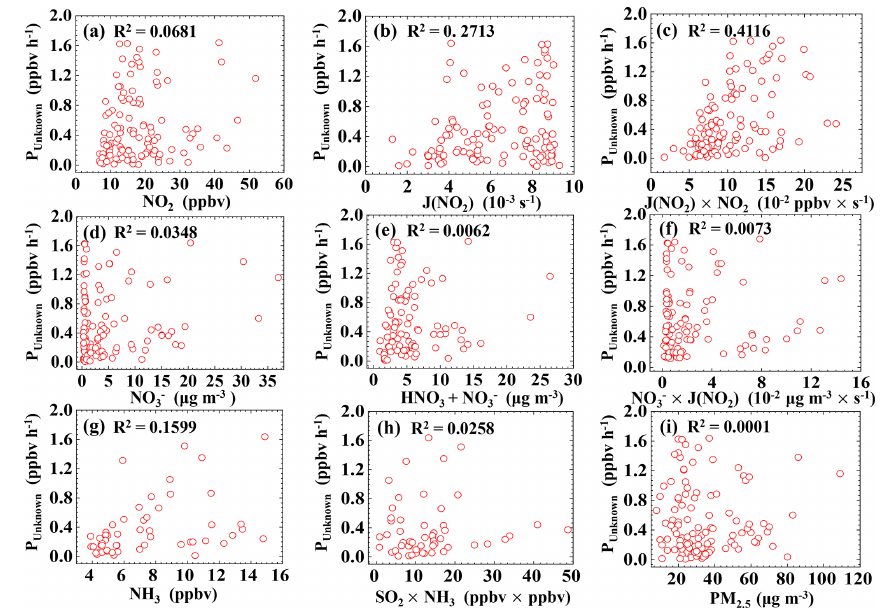
Figure 7. Correlations between the unknown daytime HONO source P Unknown and related parameters.